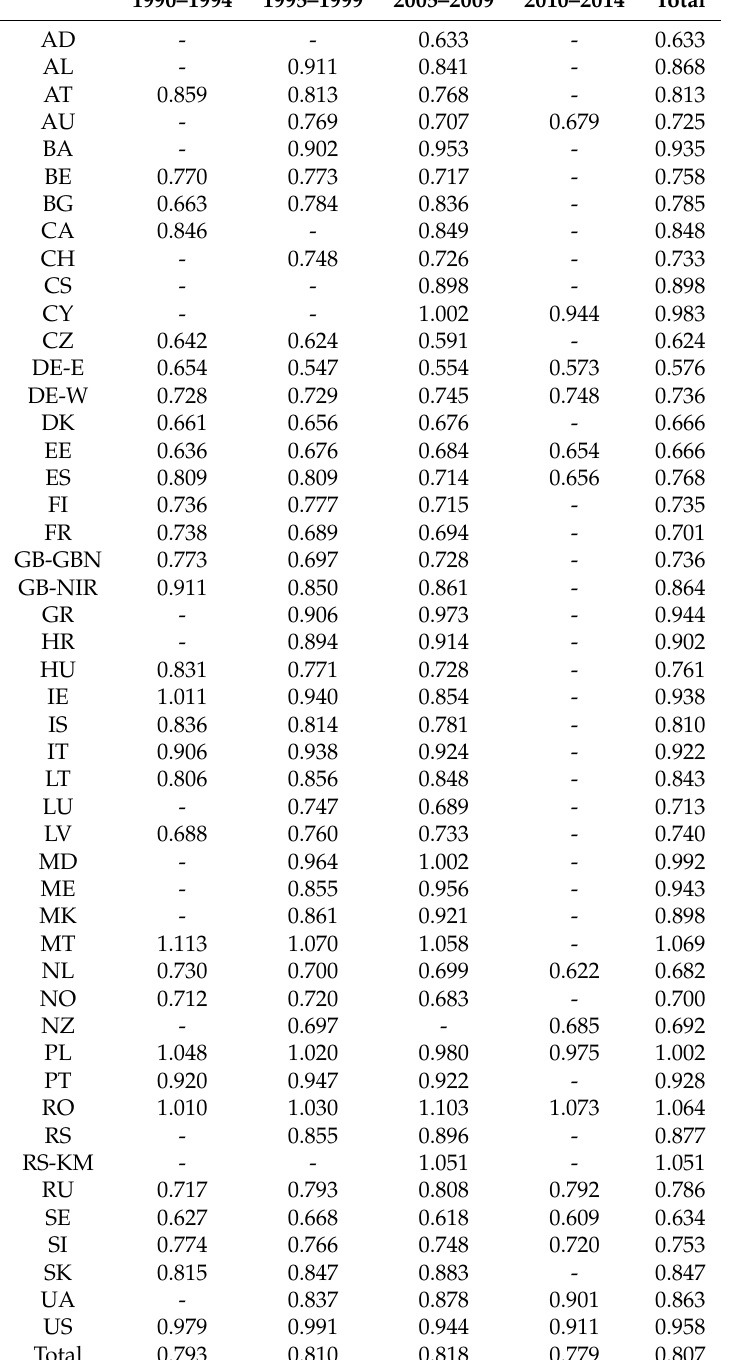
Table A6. The mean of the relative importance of religion by country and